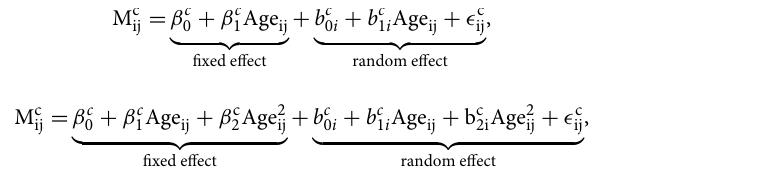
Figure 3. ( a ) Trajectories of age-related changes in a volumetric MRI measure (i.e., left-hippocampus) and random effects in four subjects for each of the four subgroups. The distance between the cohort effect and random effect ( dev ) of each subject (the green vertical lines) was included as one of the features in our statistical models. ( b ) The time-span was different between the participants in the present study. The change in ROI volume may therefore be the same for a participant with a short and long participation time, here illustrated by the red and blue line, respectively. The d-slope feature is included to capture this phenomenon 19 cohort behaviour (Fig. 5), likely caused by the accumulation of cerebrospinal fluid due to atrophy in multiple brain regions, we used linear mixed effects models both with and without a quadratic covariate term: